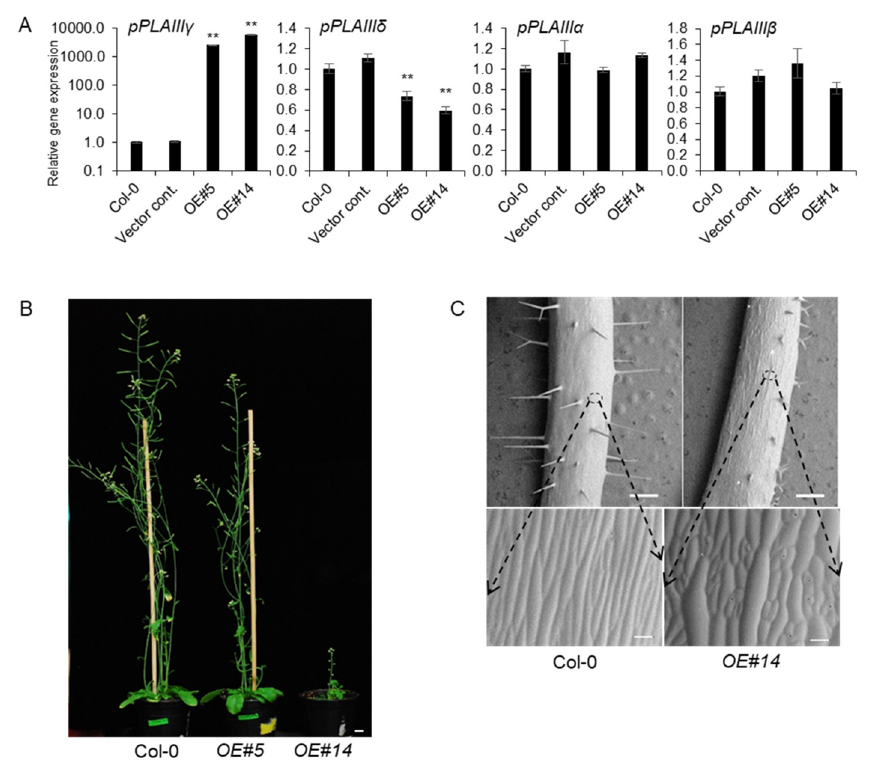
Figure 2. pPLAIII γ OE shows inhibited longitudinal growth and altered elongation pattern of epidermal cells. ( A ) Expression levels of each pPLAIII gene in 2 ‐ week ‐ old seedlings of controls and pPLAIII γ OE . Each data point represents the average ± SE of three independent replicates at p < 0.05 (*) and p < 0.01 (**), respectively. ( B ) Growth phenotype of 7 ‐ week ‐ old Col ‐ 0 and pPLAIII γ OE . Scale bars = 1 cm. ( C ) Epidermal cell growth patterns are altered in the pPLAIII γ OE lines. All images were taken using a low ‐ vacuum scanning electron microscope (JSM ‐ IT300, JEOL, Seoul, Korea) at 10.8 mm working distance and 20.0 kV.